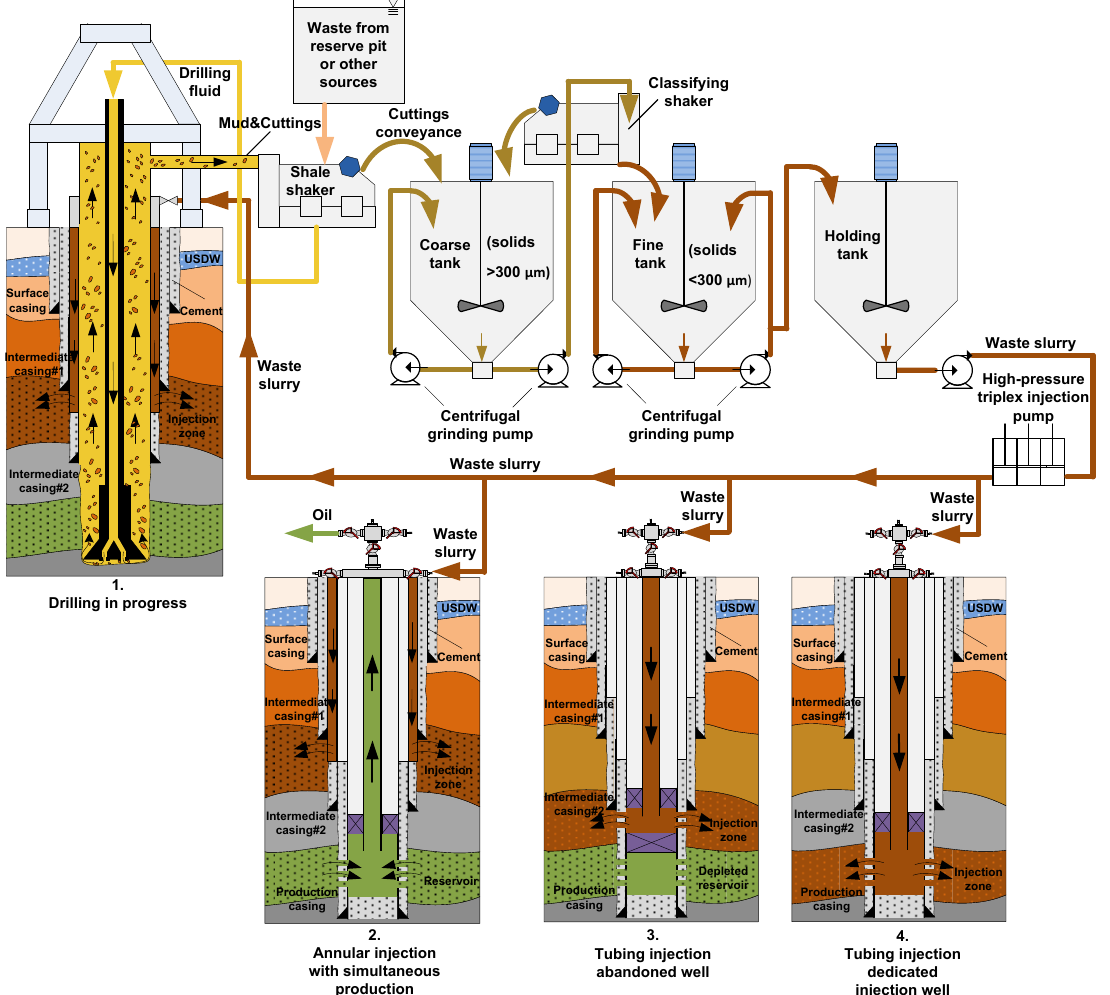
Figure 2. Waste slurry preparation and disposal unit.